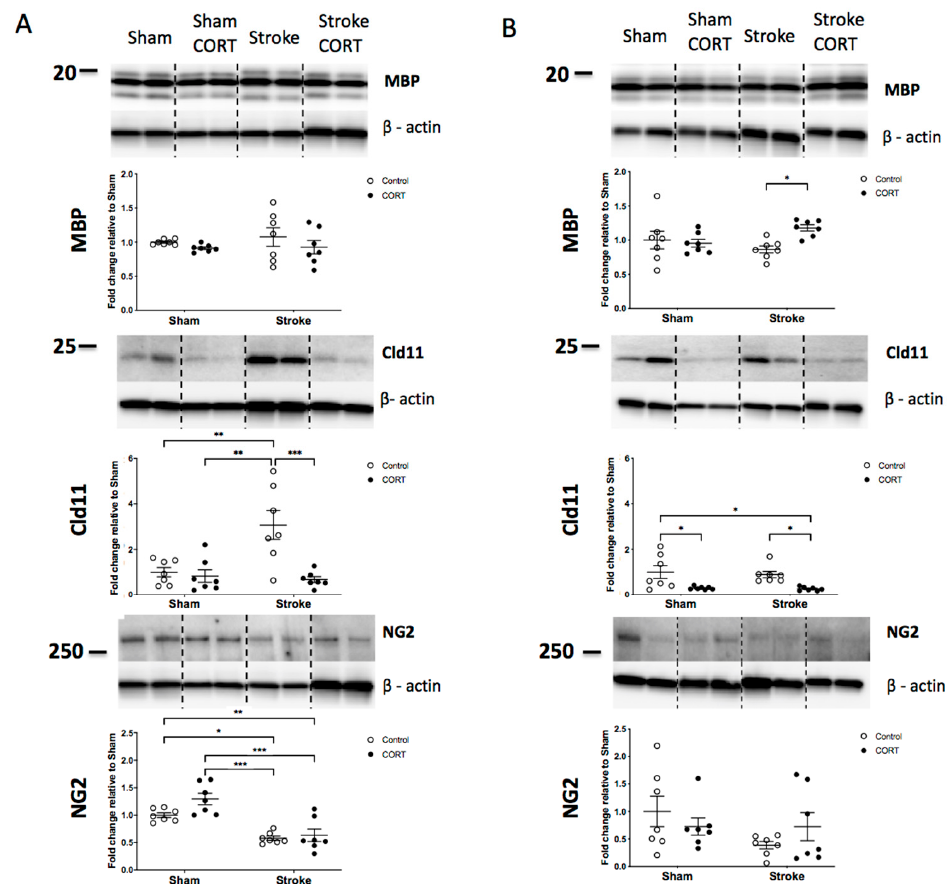
Figure 3. Protein expression after stroke and corticosterone (CORT) administration. Both panels show representative Western blots and quantitation of white matter tract specific proteins: myelin basic protein (MBP), Claudin-11 (Cld11) and neuroglial antigen 2 (NG2) in ( A ) the corpus callosum (CC) and ( B ) the corticospinal tract (CST). Data on graphs are expressed as mean ± SEM *** p < 0.001, ** p < 0.01, * p < 0.05.